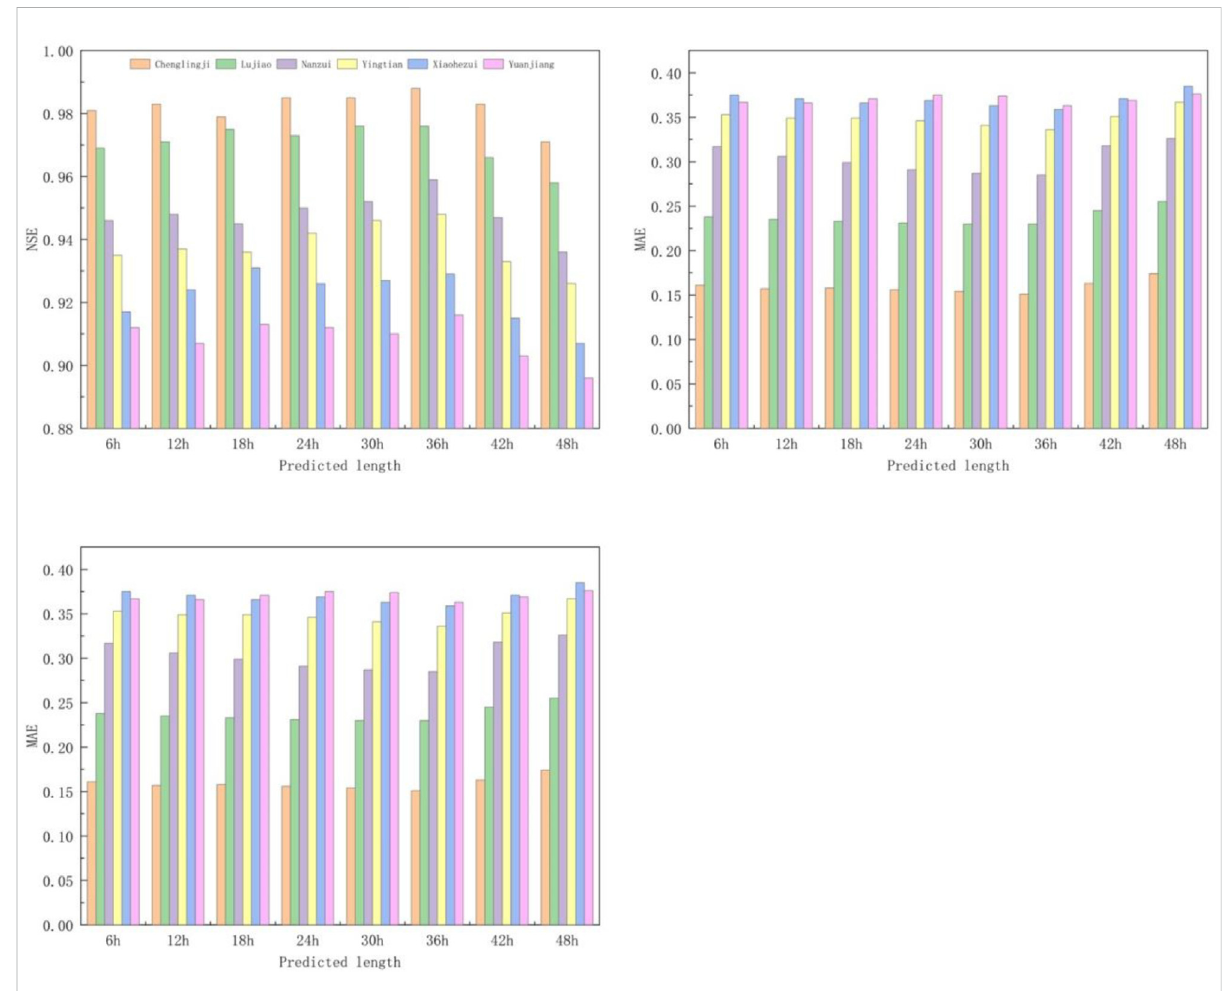
FIGURE 8 Performance of the selected PSO-ENN model under different time advances conditions (lag time).